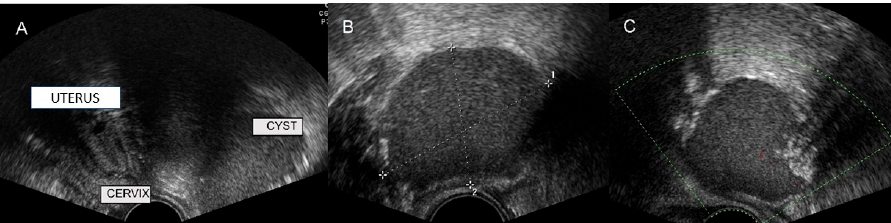
19 of 21 Figure 27. Color Doppler transvaginal ultrasound shows in the right adnexal region, a well-defined solid mass with cystic areas and scattered vessels in a patient with histological result of neurofi-